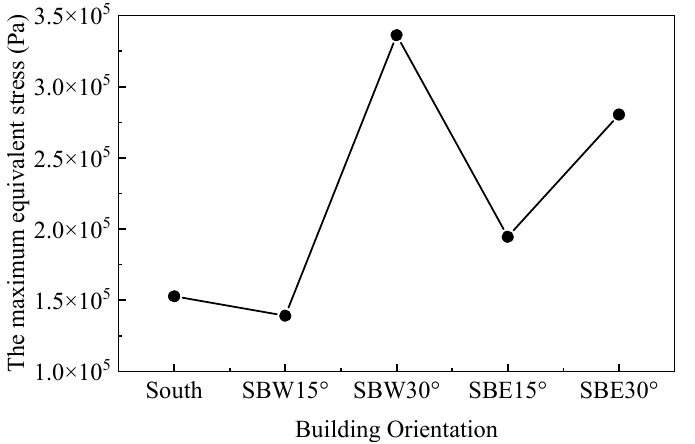
Figure 16. The comprehensive maximum equivalent stress of 5 building orientations under 2 wind direction conditions.